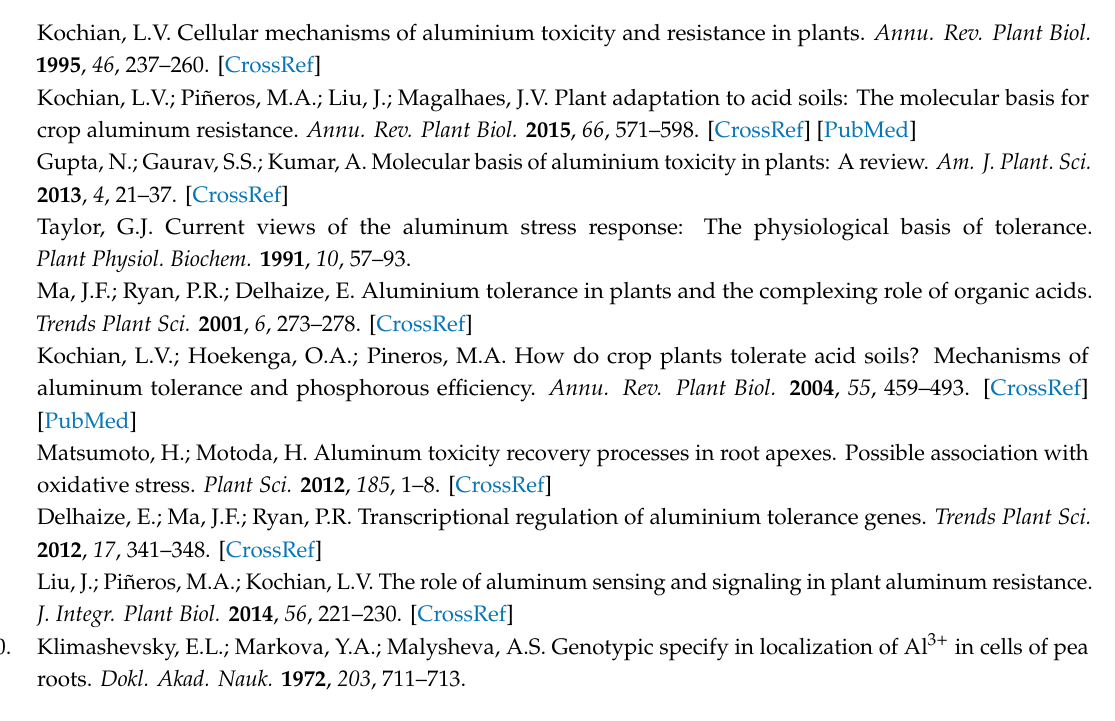
Figure S1: Root colonization by Pseudomonas fluorescens SPB2137 of pea genotypes VIR1903, VIR7307, VIR8353 and VIR8473 inoculated with microbial consortium and grown in neutralized or Al-supplemented soil, Table S1: Concentration of nutrients in the rhizosphere of pea genotypes inoculated with microbial consortium and grown in neutralized or Al-supplemented soil, Table S2: Concentration of nutrients in shoots of pea genotypes inoculated with microbial consortium and grown in neutralized or Al-supplemented soil, Table S3: Concentration of nutrients in seeds of pea genotypes inoculated with microbial consortium and grown in neutralized or Al-supplemented soil, Table S4: Alpha diversity indices for the rhizosphere prokaryotic microbiomes of pea